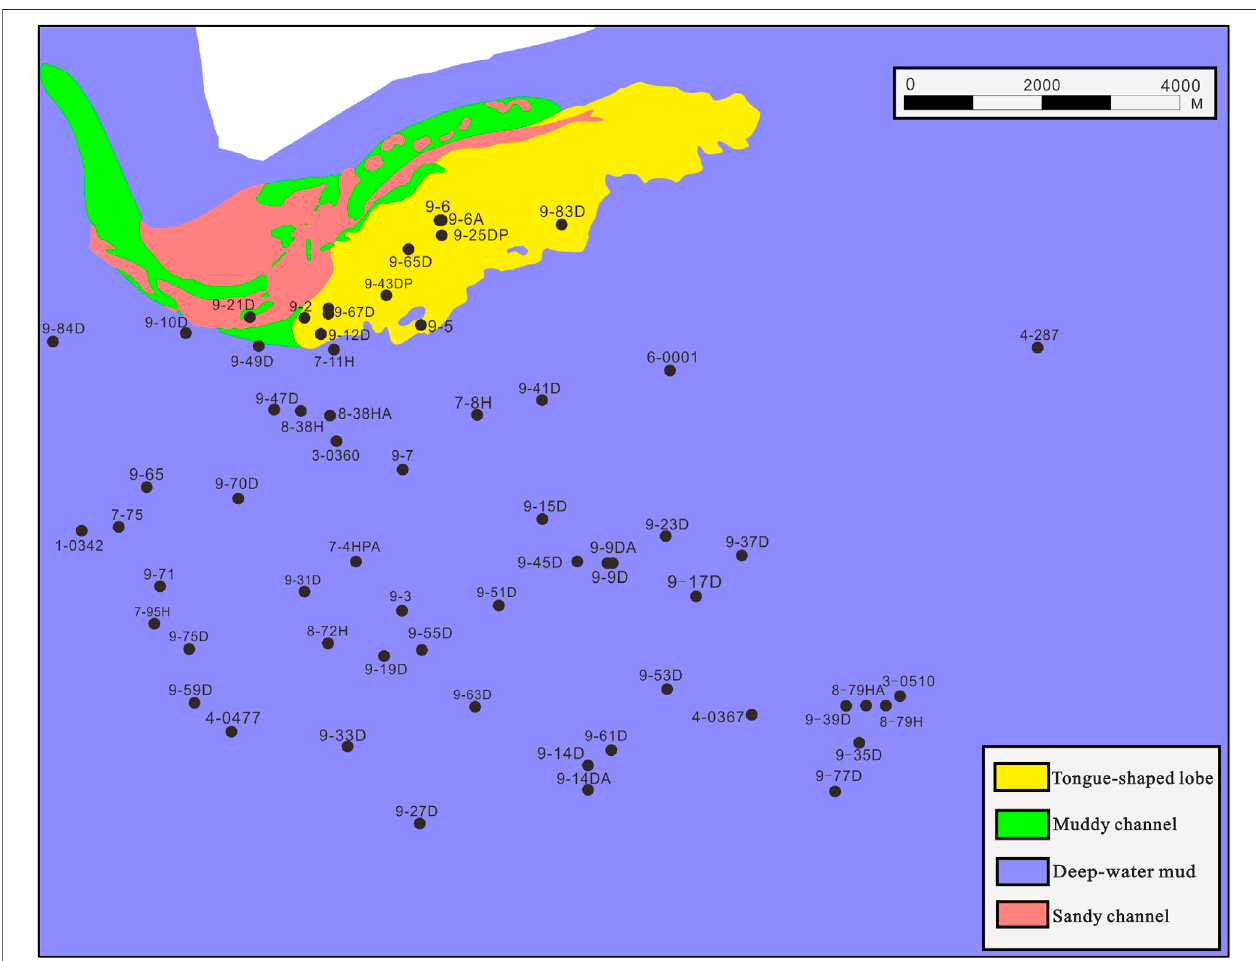
FIGURE 10 | Sedimentary microfacies distribution model for the AB120 Formation based on the integrated well-log and seismic data.